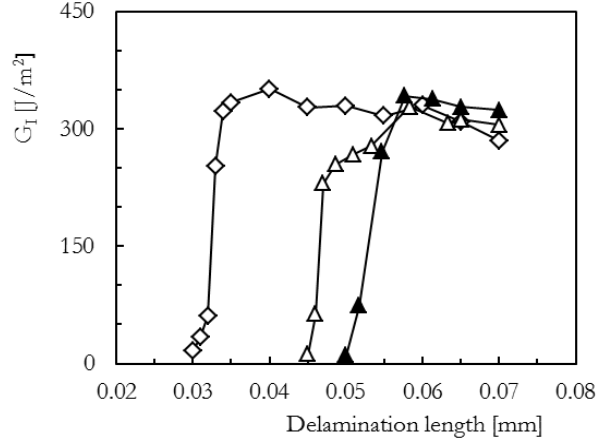
Figure 5: G I versus crack